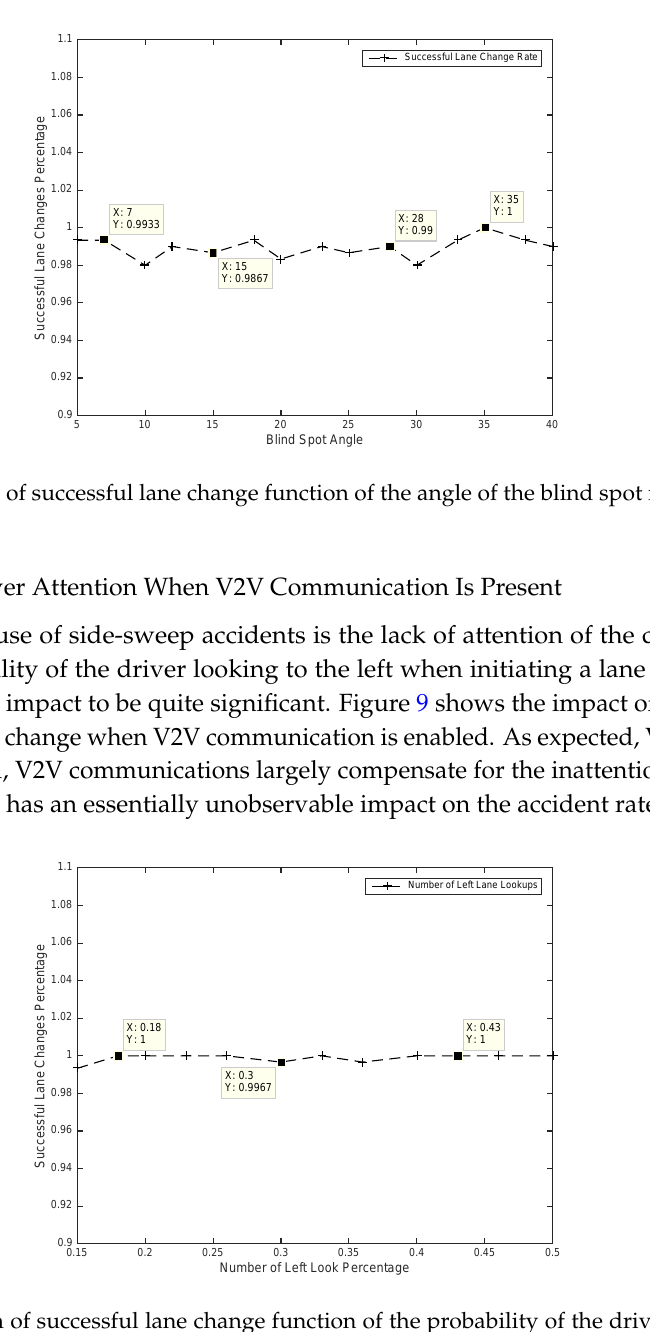
Figure 9. The fraction of successful lane change function of the probability of the driver looking before initiating the change, in the presence of V2V